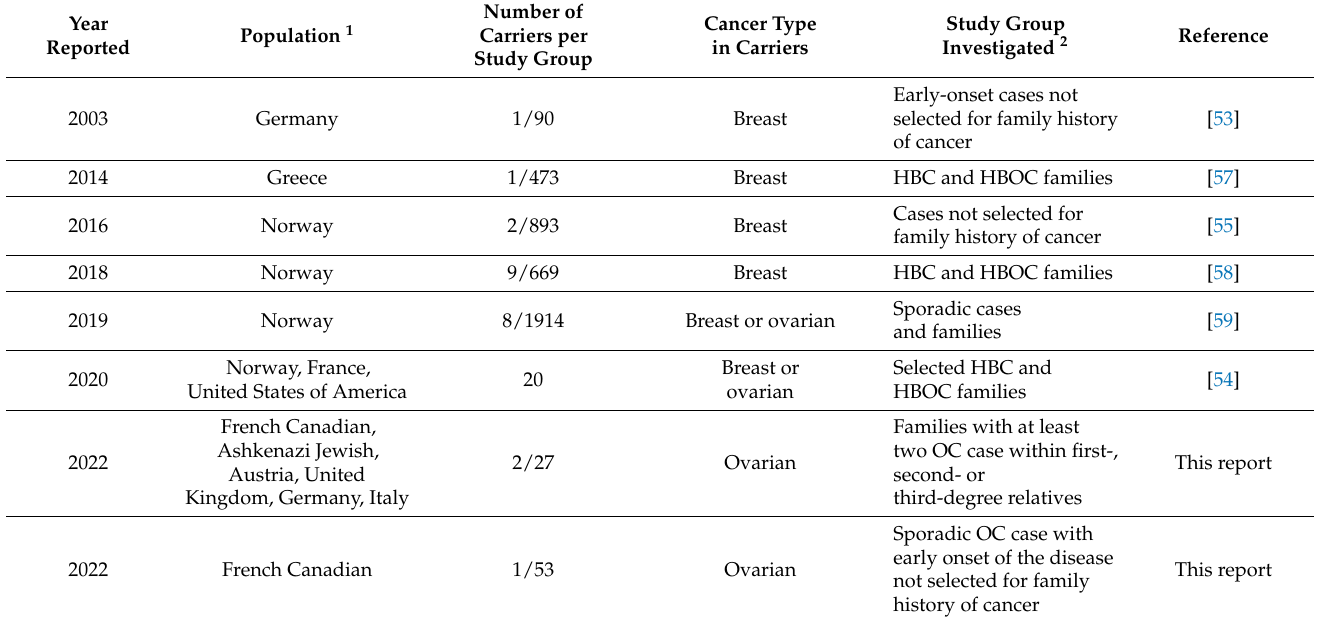
Table 1. Features of BRCA1 c.5407-25T>A carriers from independent